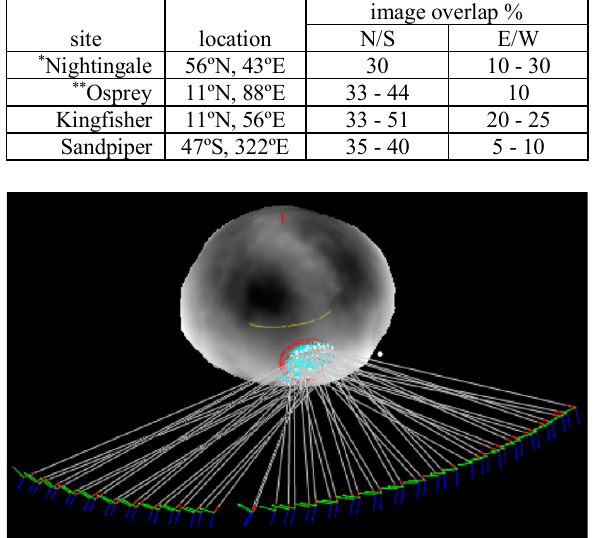
Figure 7. Spacecraft locations for Reconnaissance A image acquisition of site Sandpiper, displayed in J-Asteroid. Note the lack of diversity in camera station geometry.